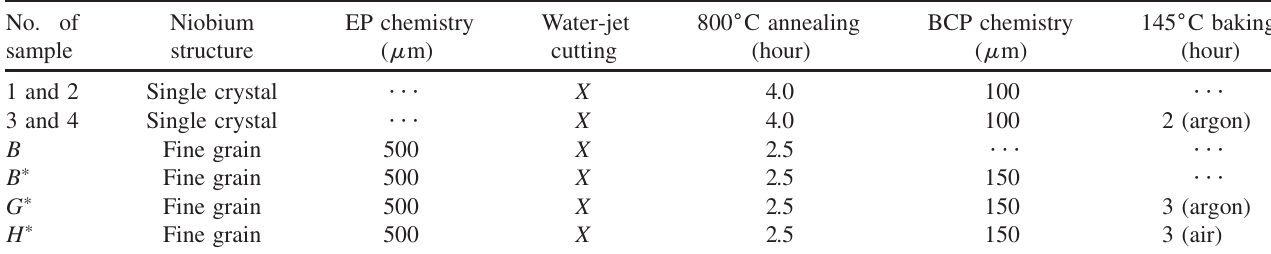
TABLE I. Characteristics and treatments of niobium samples.